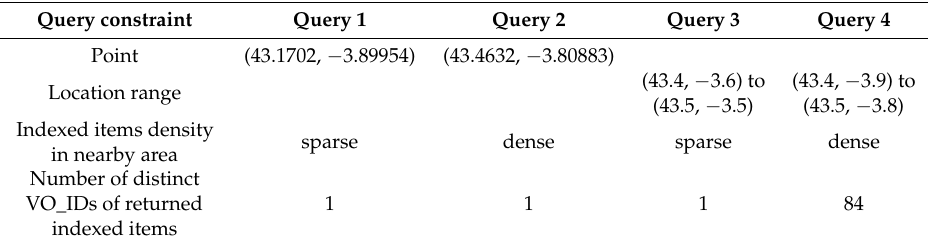
Table 6. Query Constraints and Number of Query Results from Tree Structures.